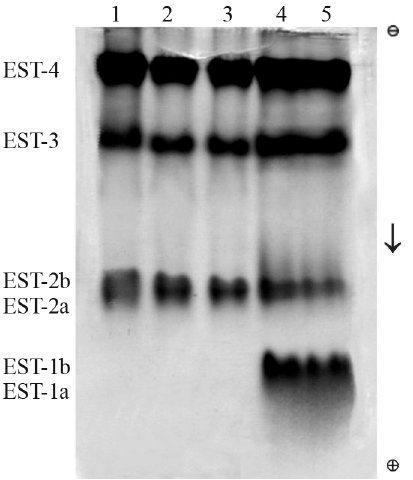
Figure 1 - Gel profile of general esterase hydrolytic activity in an experi- mental Boophilus microplus tick strain from Brazil. Protein extracts were separated on 12% (w/v) polyacrylamide gel and stained in the presence of (cid:2) -naphthyl acetate. Lanes: (1) sensitive Mozzo reference strain; (2-3) cypermethrin susceptible strain (S); (4-5) cypermethrin resistant strain (R) as judged by the field resistance test described in the